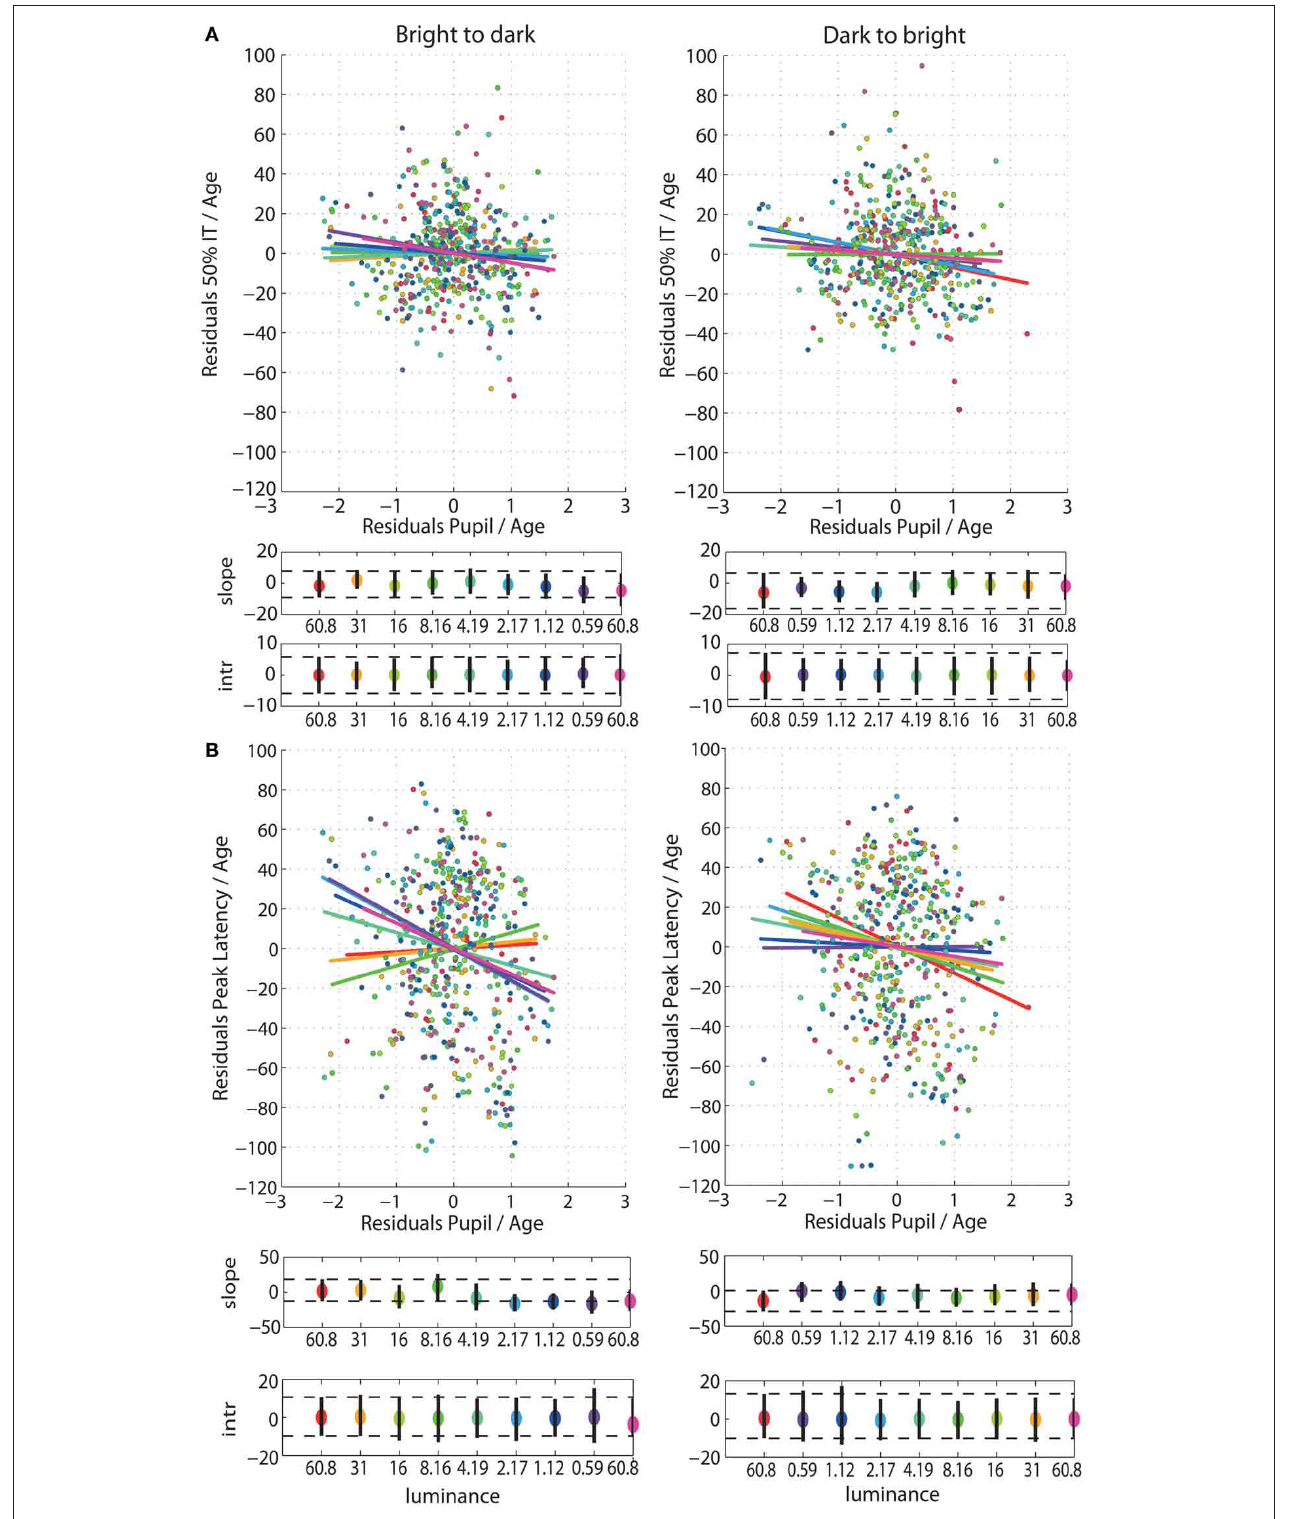
FIGURE 7 | (A) Regressions of residuals of 50IT/age against residuals of pupil size/age for all luminance levels. (B) Regressions of residuals of peak latency of face-texture ERP differences/age against residuals of pupil size/age for all luminance levels. See Figure 4 caption for details.